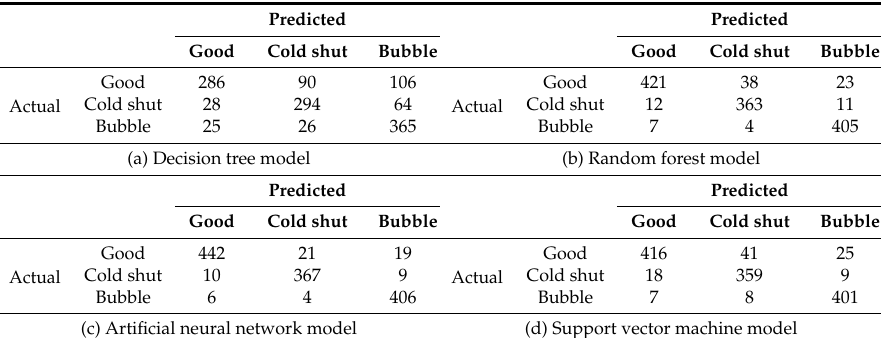
Table 6. Prediction results of each quality-prediction model.